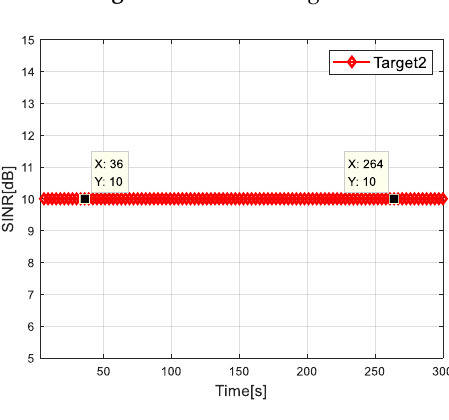
Figure 6. SINR for target 1.